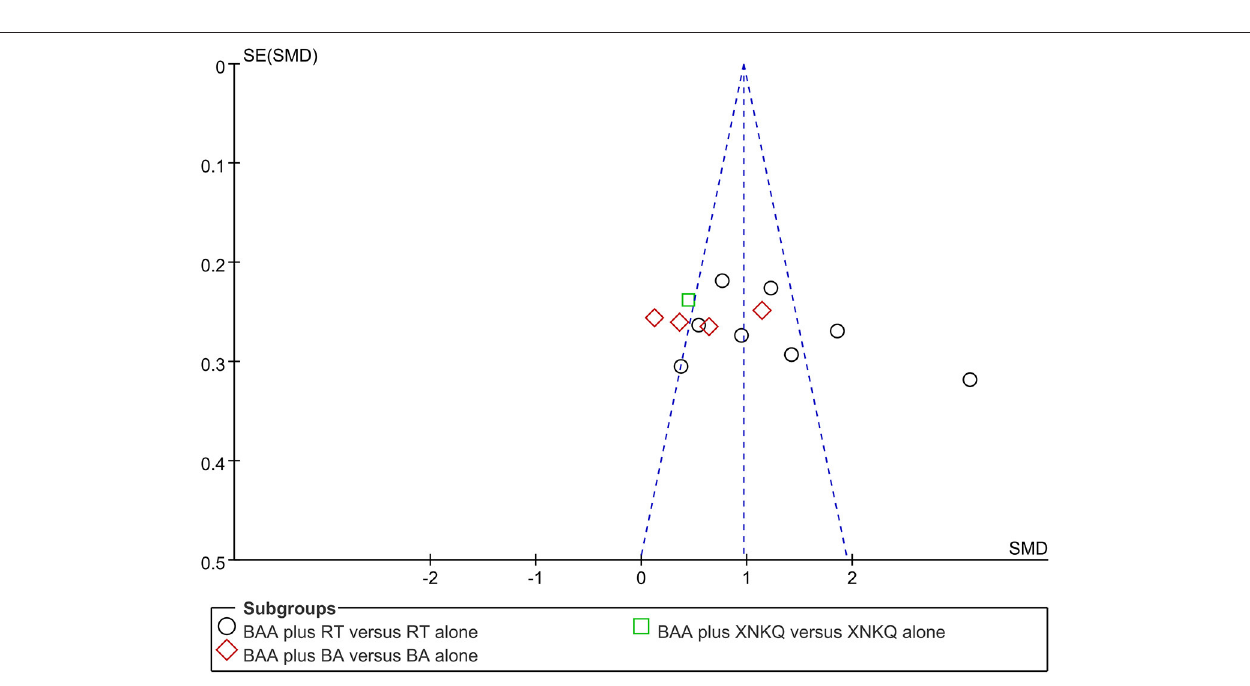
FIGURE 8 | Funnel plots illustrating meta-analysis of MBI. (BA, body acupuncture; BAA, Bo’s abdominal acupuncture; MBI, modified Barthel Index; SMD, standardized mean difference; SE, standard error; RT, rehabilitation training; XNKQ, Xingnao kaiqiao